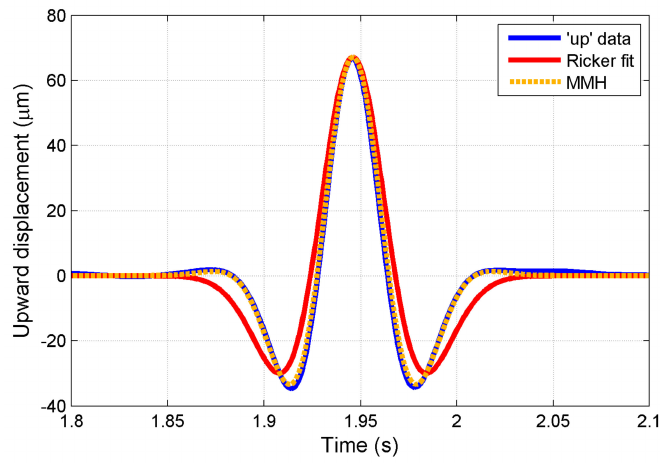
Figure 3. Finite element (FE) time series data, showing vertical (upward) displacement versus two mathematical fit